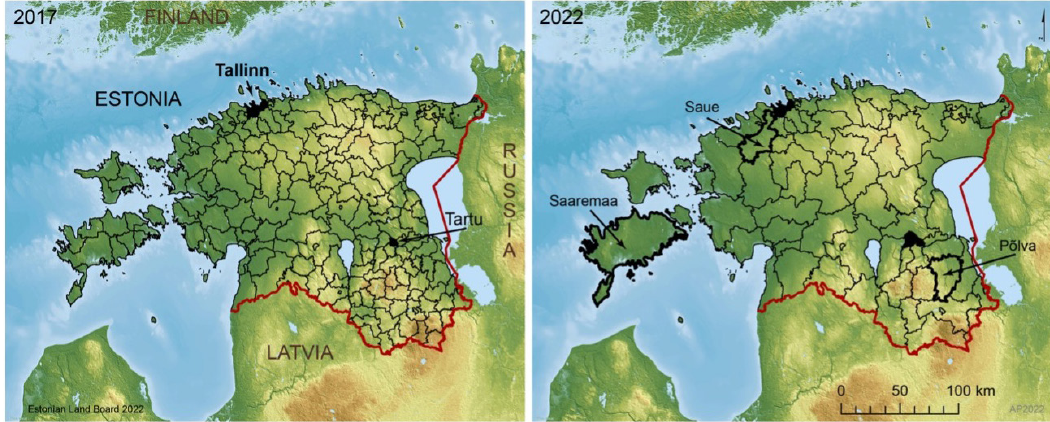
Fig. 1. Estonian municipalities before and after administrative reform and case study areas (Author: Anu